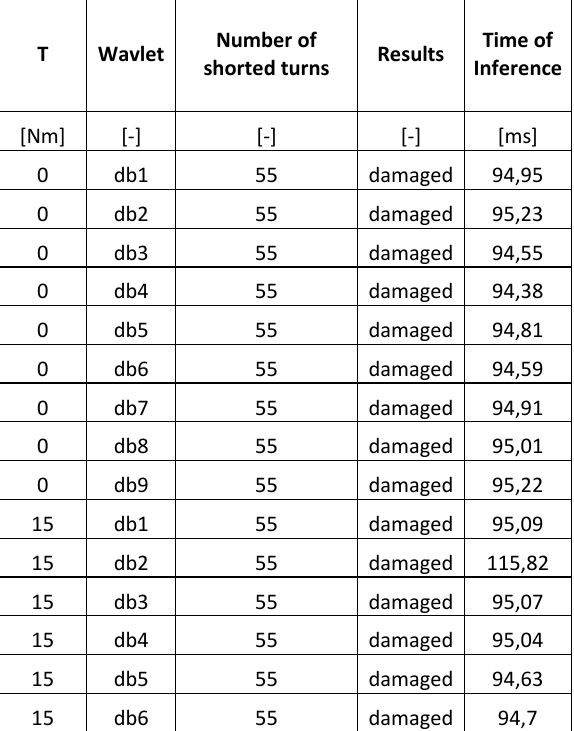
Fig. 2. Network responses for a different number of shorted turns. Table 1. The results of inference for 55 shorted